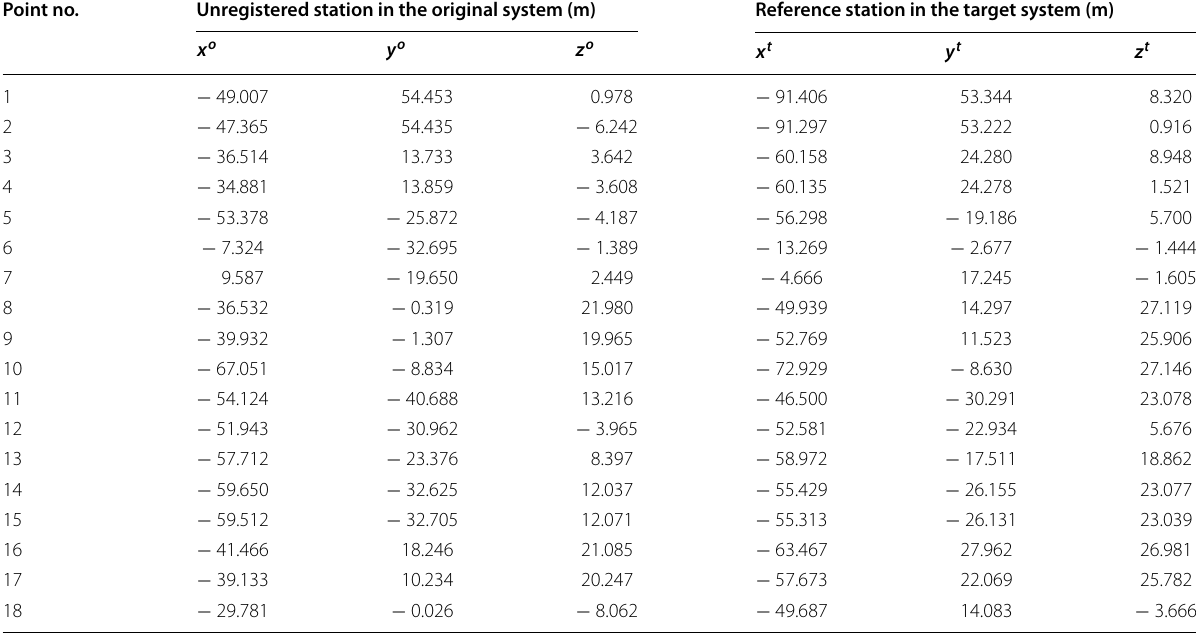
Table 6 Common points extracted from two neighboring LIDAR point clouds Point no.